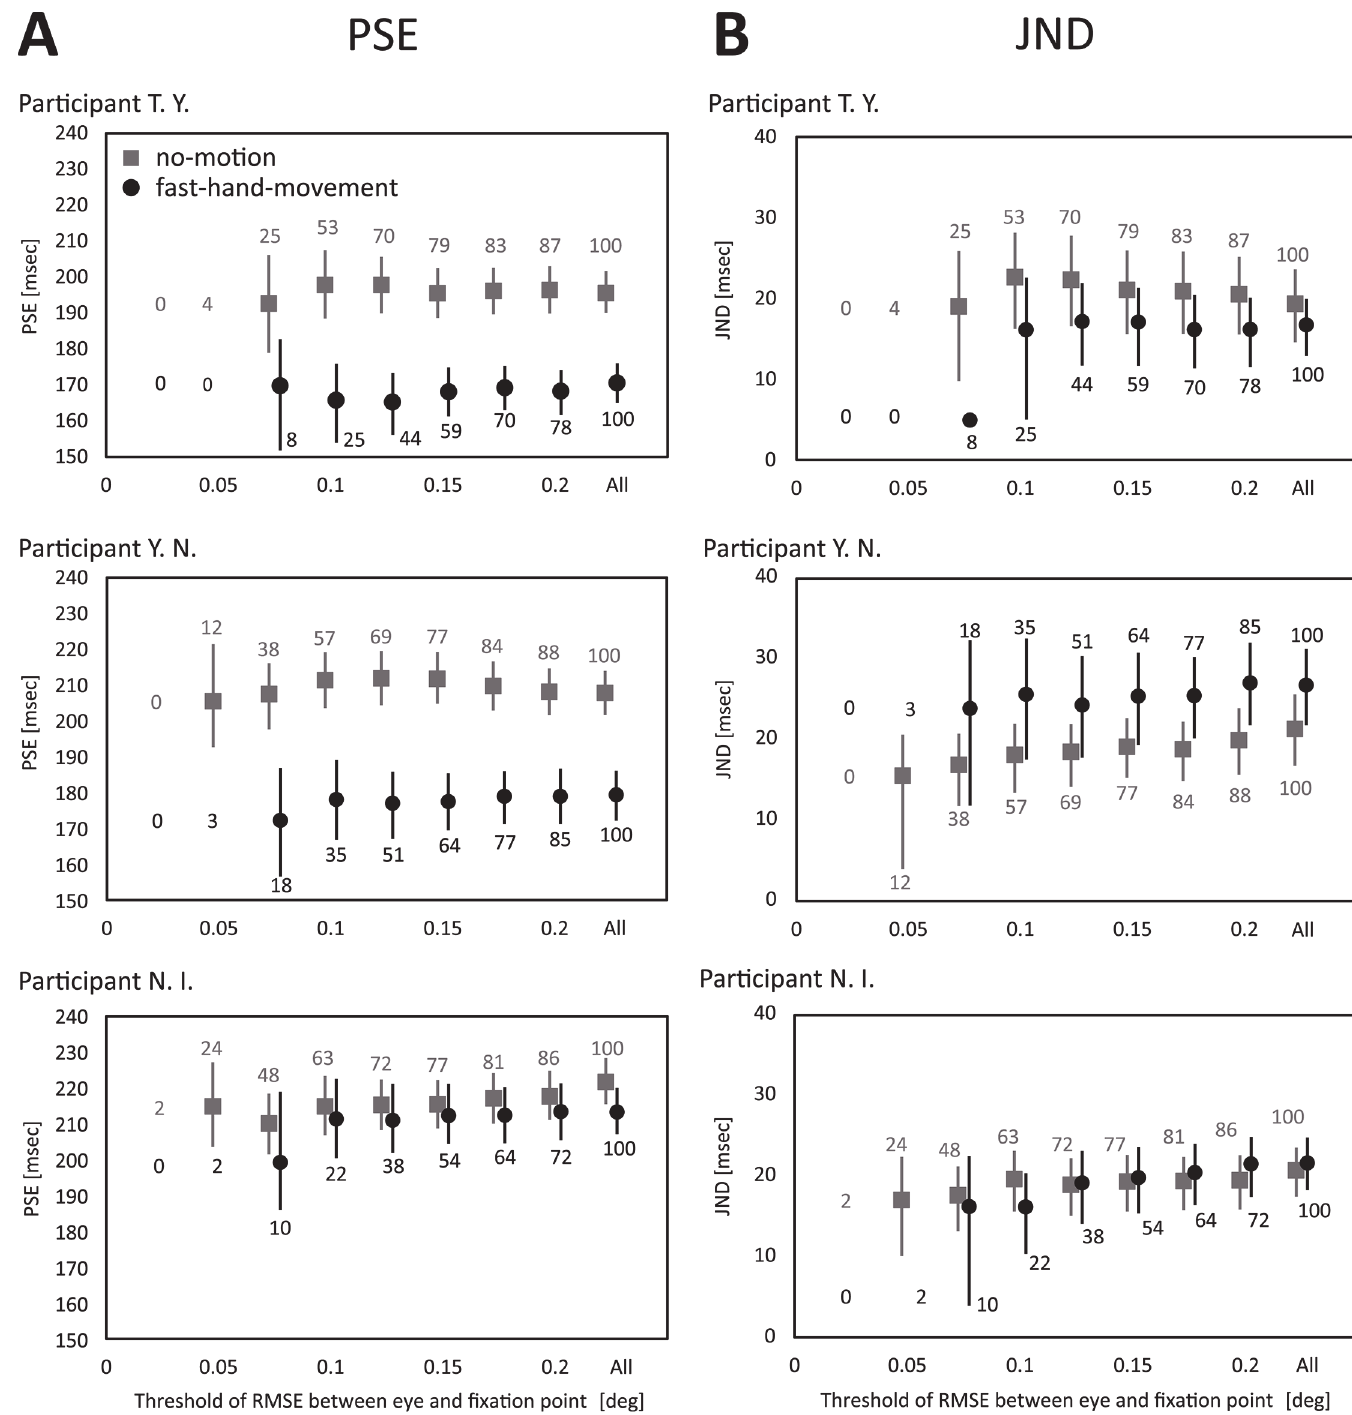
Fig 4. The PSEs and JNDs in the supplementary experiment (n = 3). Symbols indicate individual data points and error bars denote the 95% confidence interval calculated by bootstrap method [22]. The trials whose RMSE of eye movement exceeded the threshold were excluded from data analysis. The numbers at each data point indicate the rate of the number of sample data used to analyze all sample data (%). 100 (%) means that all 60 sample data were used in data analysis.